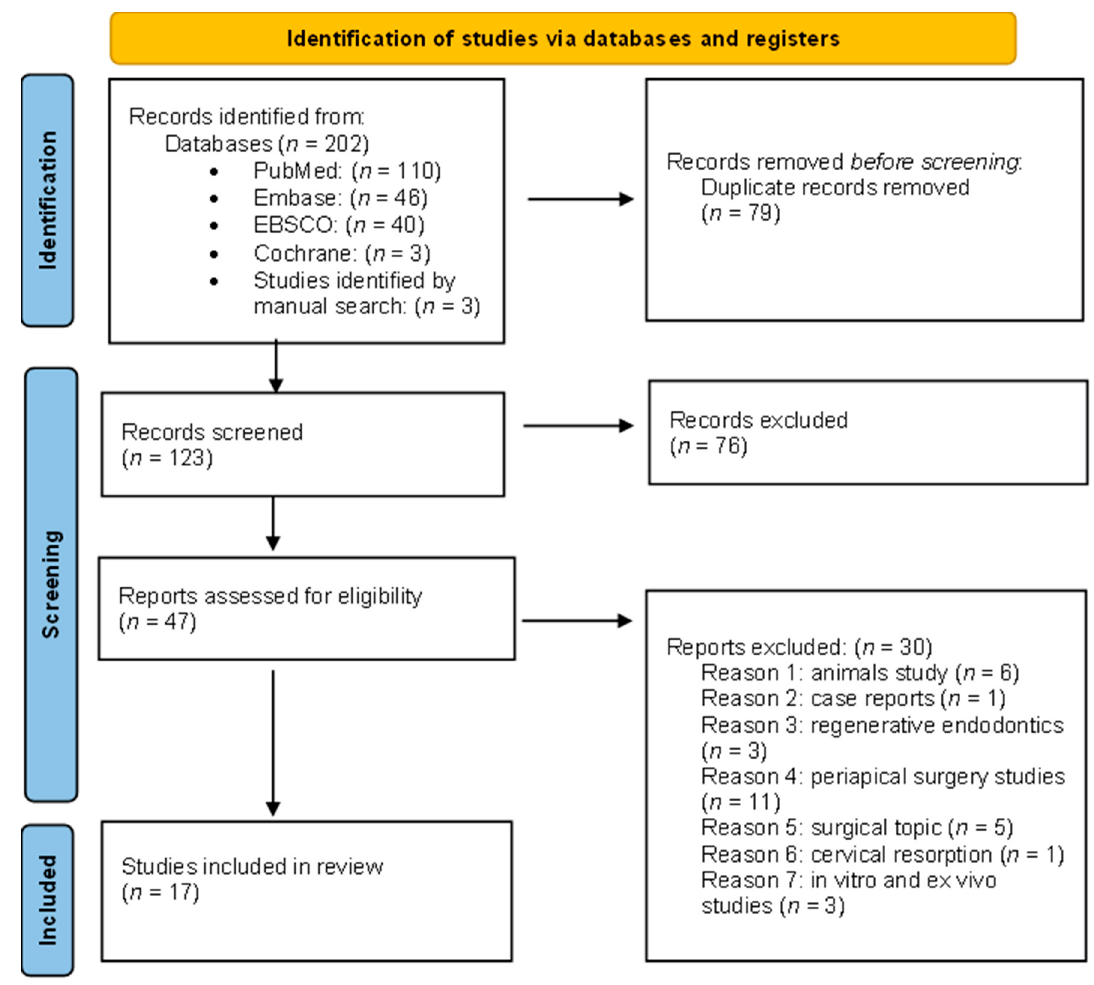
Figure 1. Preferred Reporting Items for Systematic Reviews and Meta- Analyses flowchart of study selection.